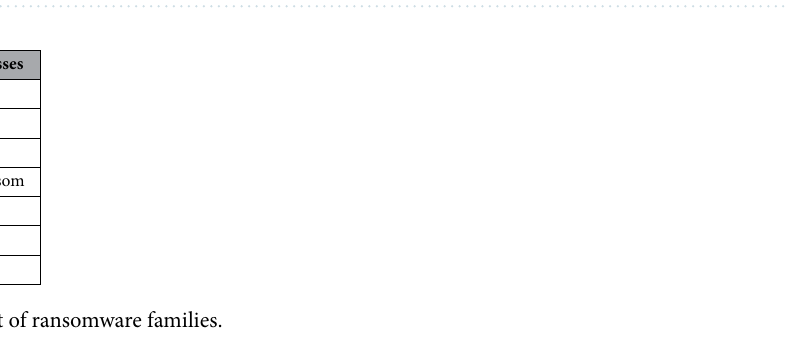
Figure 2. Ransomware family vs. no of samples.